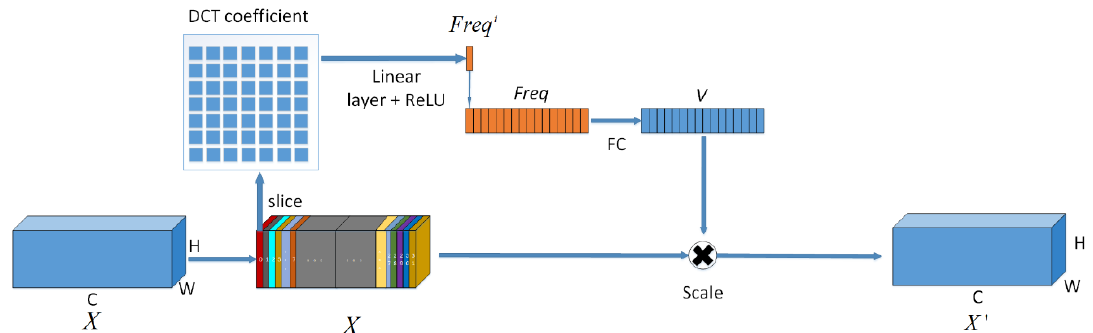
Figure 4. The network structure of AFcaNet.